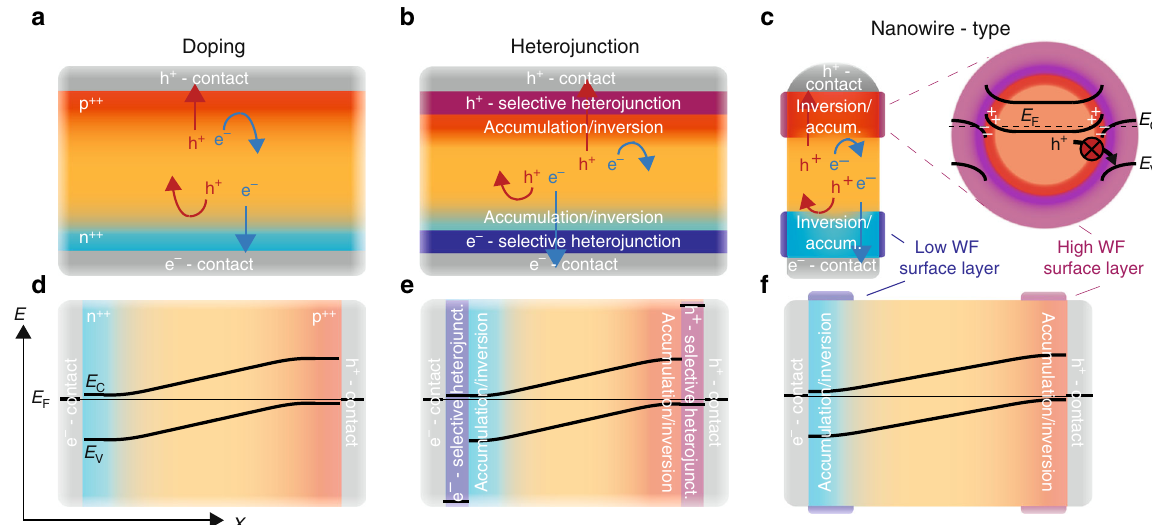
Fig. 1 Different types of charge carrier-selective contacts. a Contact selectivity of traditional solar cells is determined by the doping density of the semiconductor directly underneath the metal contact. b Contact selectivity of heterojunction solar cells is determined by the induced accumulation/ inversion region inside the semiconductor directly underneath the metal contact, due to the work function difference between heterojunction contact material and semiconductor. c Nanowires allow for a different type of charge carrier-selective contact; the carriers can be extracted parallel to the surface instead of perpendicular to it (as in doped- and heterojunction contacts) (red and blue arrows). This means that carriers are not extracted through the surface-gate layer. The cross-sectional image shows a possible band alignment and the blocking of radial hole transport at the surface-gate interface. In d − f , the band diagrams in the dark are drawn for the cases in a − c , respectively. We note that band bending in the dark is indicative for the selectivity of a contact but not a suf fi cient description. For an accurate assessment of charge carrier selectivity the quasi-Fermi level under illumination have to be considered, which have been omitted here for simplicity. The color gradient indicates the charge carrier selectivity with red being very hole selective